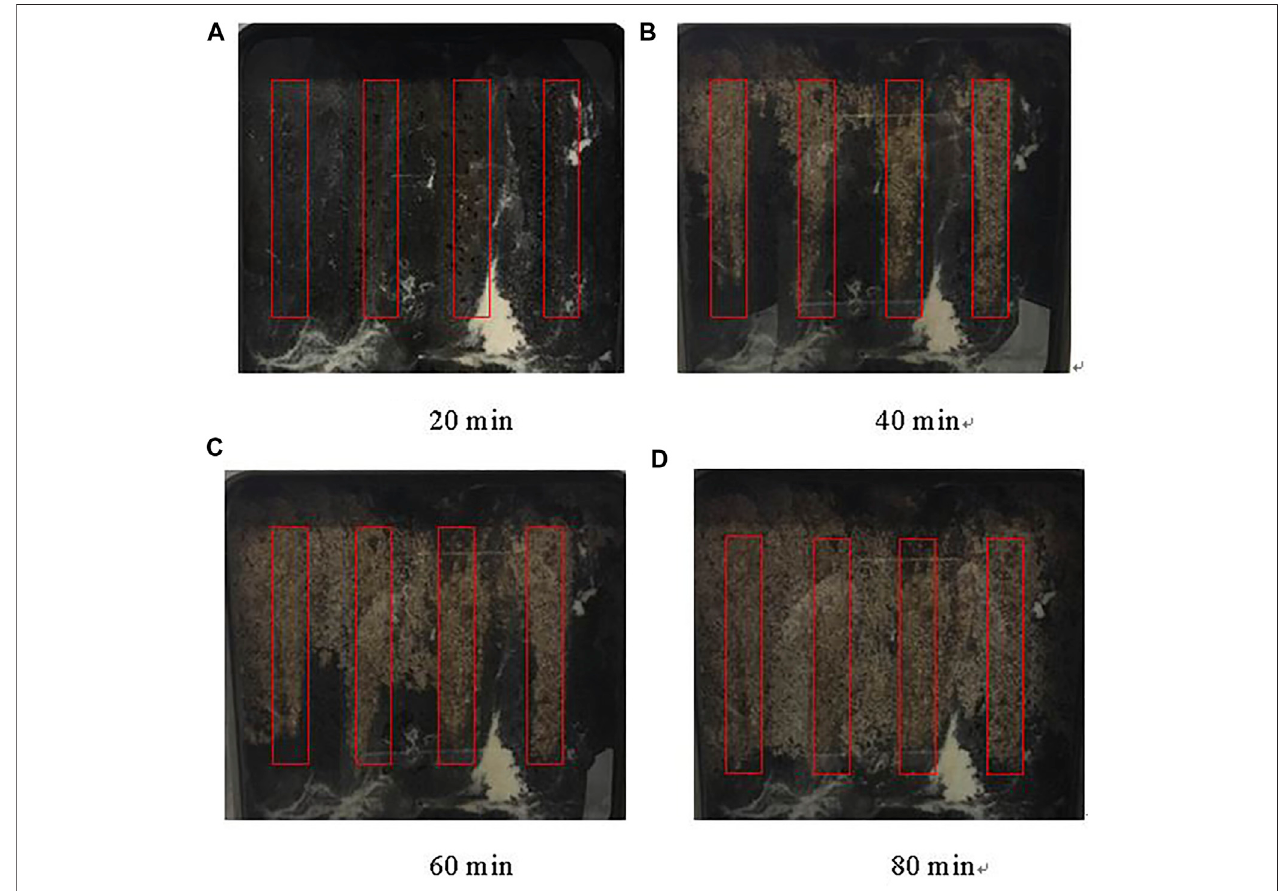
FIGURE 12 | Remaining oil distribution as a function of development time.